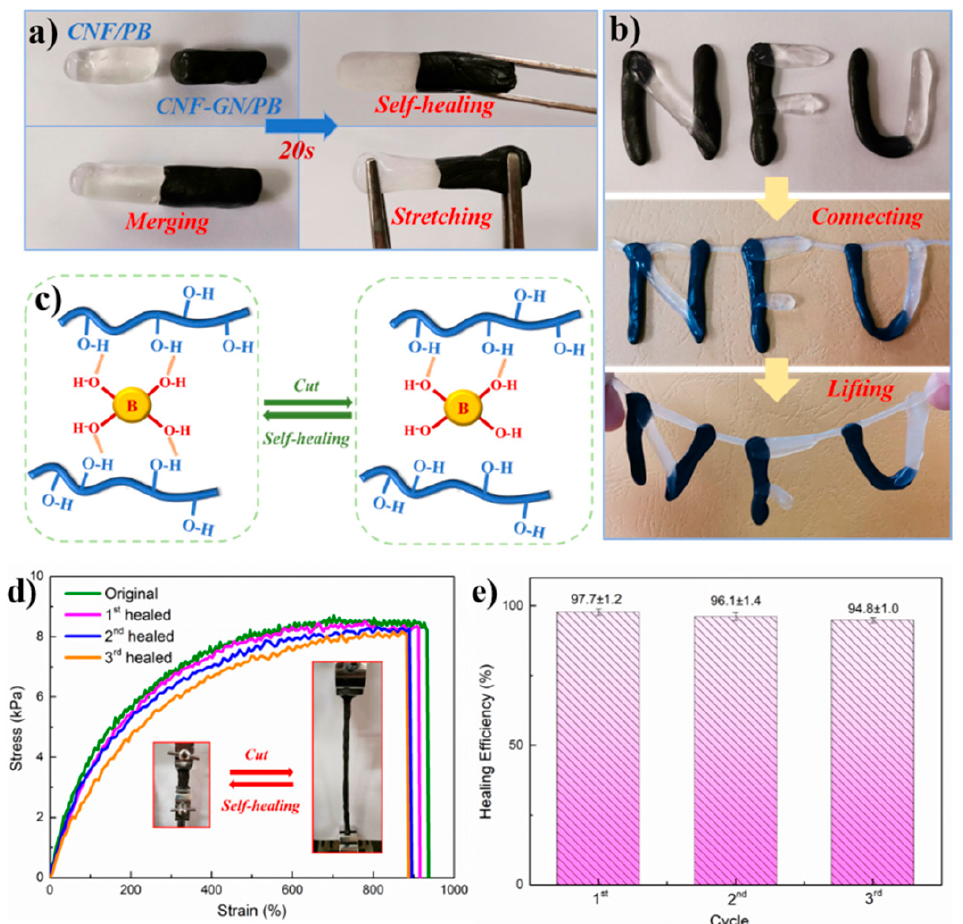
Figure 6. ( a ) The self-healing behavior of merging GN-CNF@PVA and CNF/PVA gels together; ( b ) photographs of the excellent healing ability in the different words for GN-CNF@PVA and CNF/PVA hydrogels; ( c ) self-healing mechanism of GN-CNF@PVA hydrogel; ( d ) stress-strain plots of original and self-healed GN-CNF@PVA-B hydrogels; ( e ) the values of healing efficiency in elongation at break after multiple breaking/healing cycles.